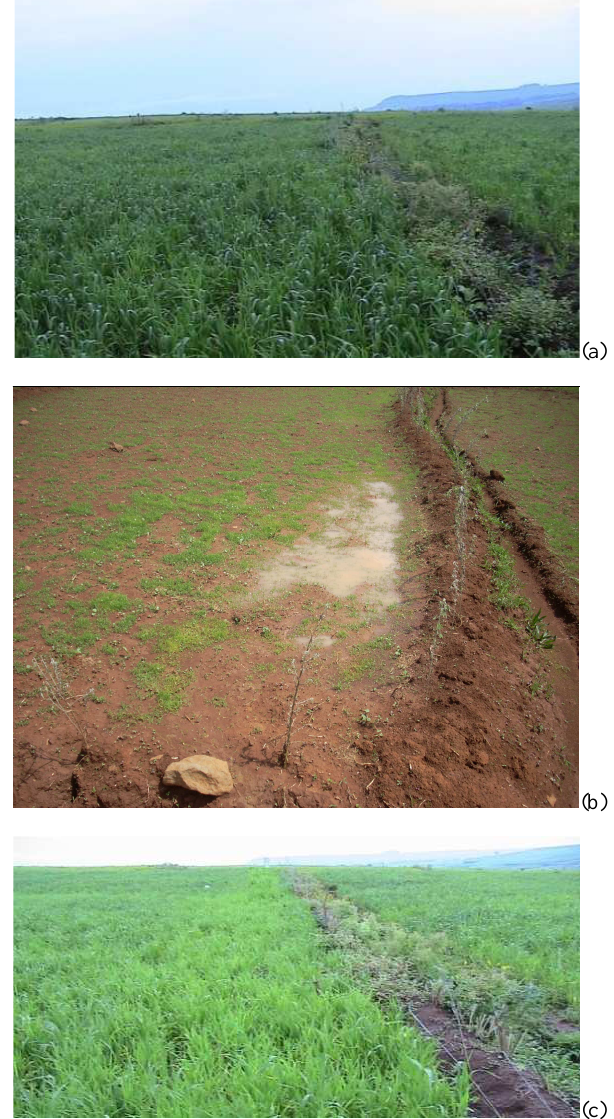
Fig. 8. Wheat fields: (a) conservation tillage (CT) fields are